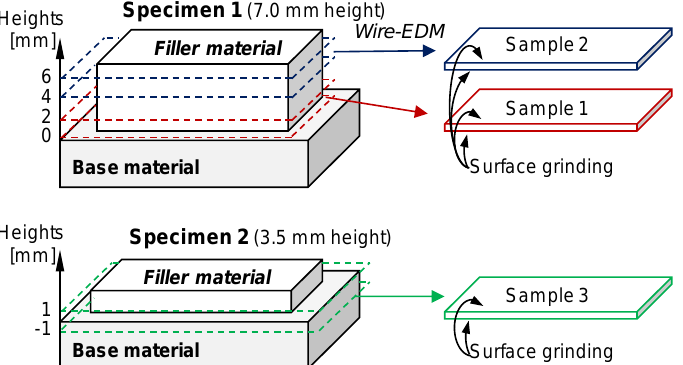
Figure 2. Sample extraction for thermal diffusivity measurements.